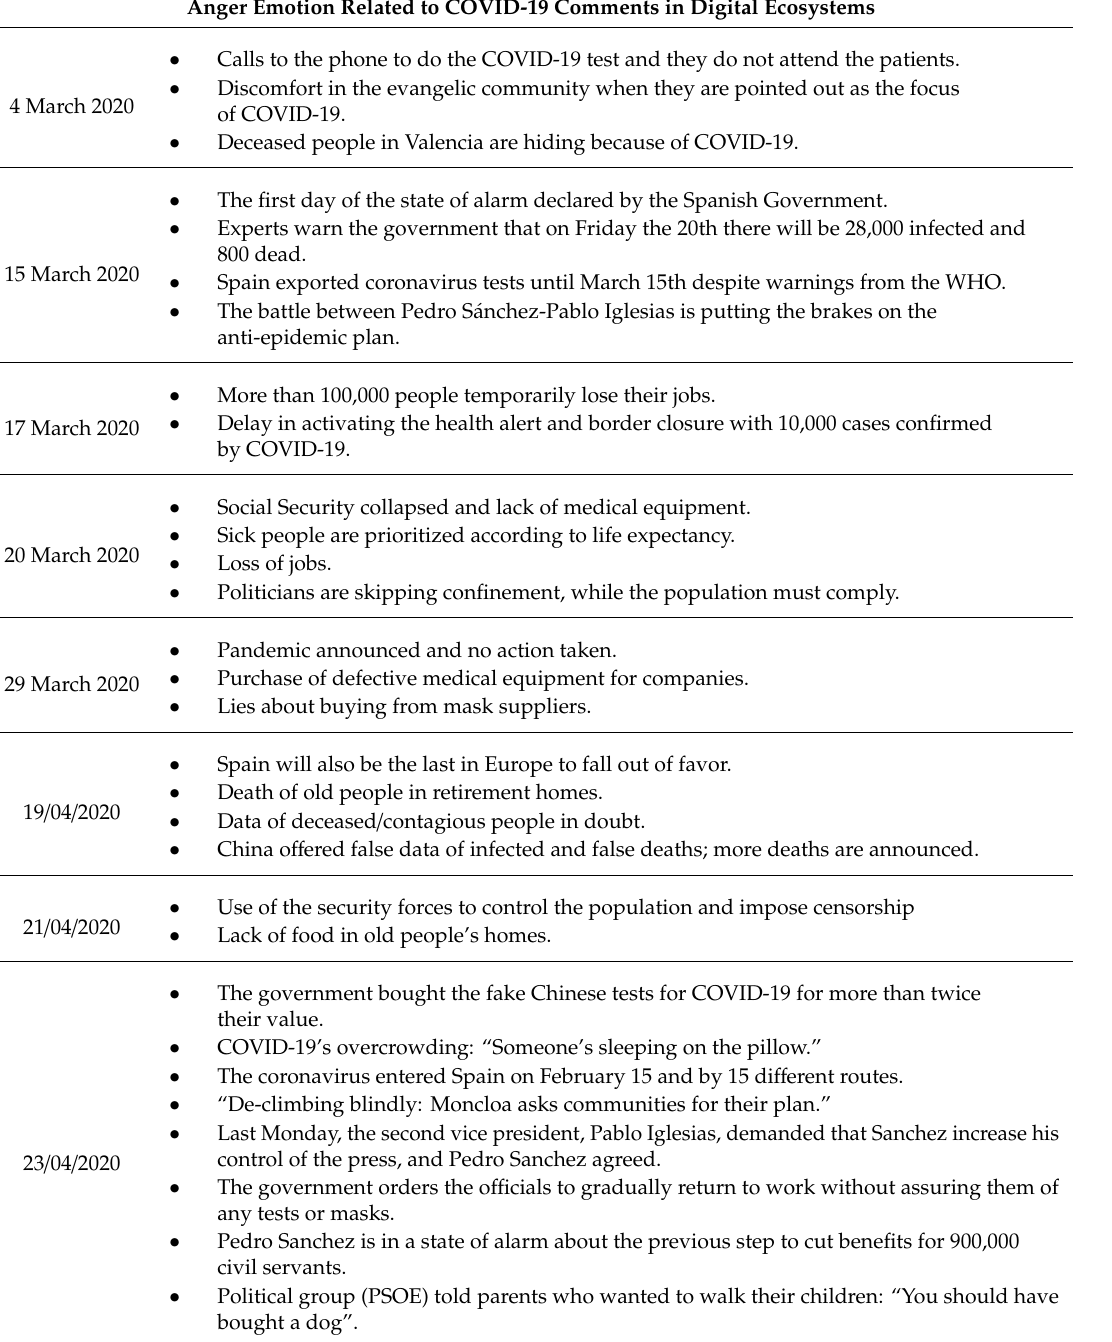
Table 3. Comments related to Anger emotion and COVID-19 in digital